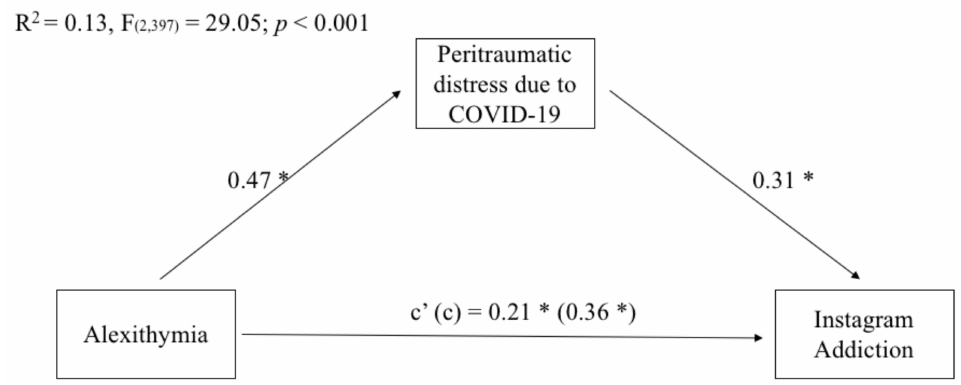
Figure 3. Mediation of emerging adults’ peritraumatic distress due to COVID on the relationship between their levels of alexithymia and Instagram addiction. Coefficients shown are standardized path coefficients. c’ = direct effect; c = total effect. * p <